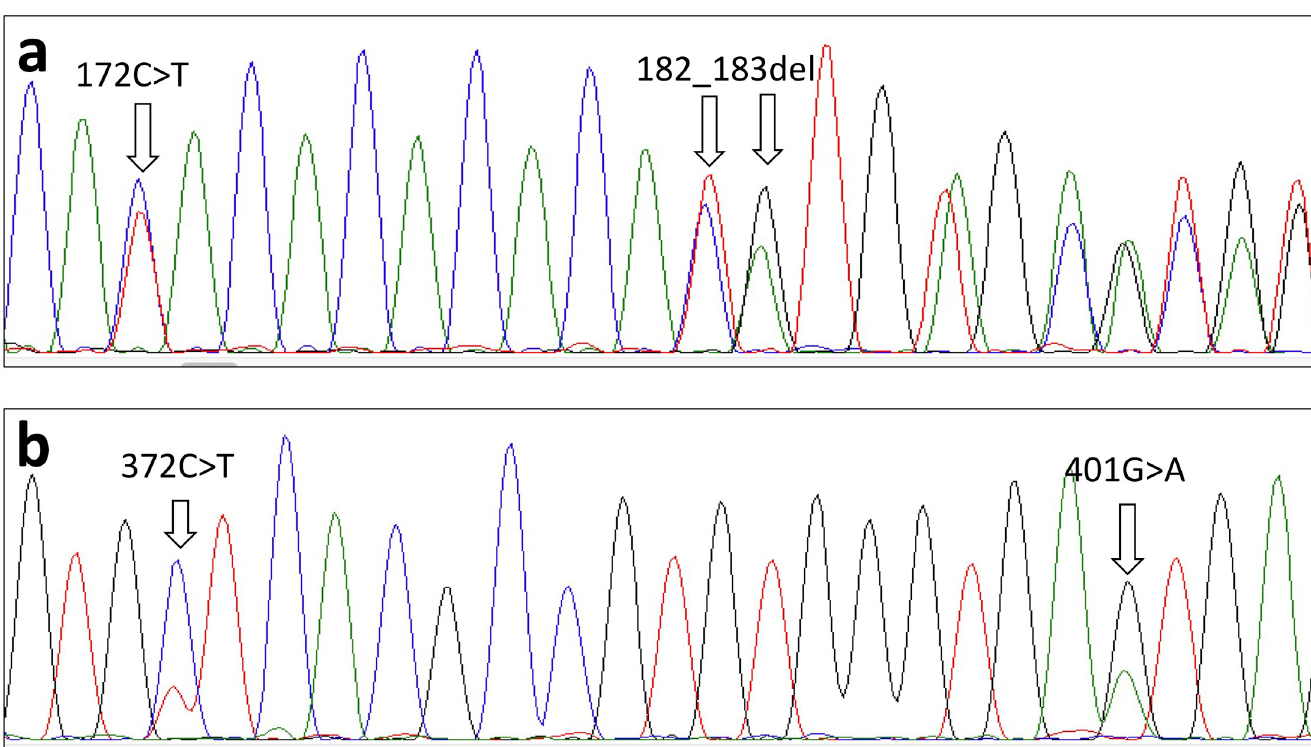
Fig 3. Snapshots of portions of ITS2 chromatogram showing polymorphic sites. Polymorphism 172C > T and 182_183del can be seen in forward sequence (a) and 372C > T and 401G > A can be seen in reverse sequence (b) chromatogram. The ambiguity (mixed bases) in sequences can be seen from the point of indel onwards (a).